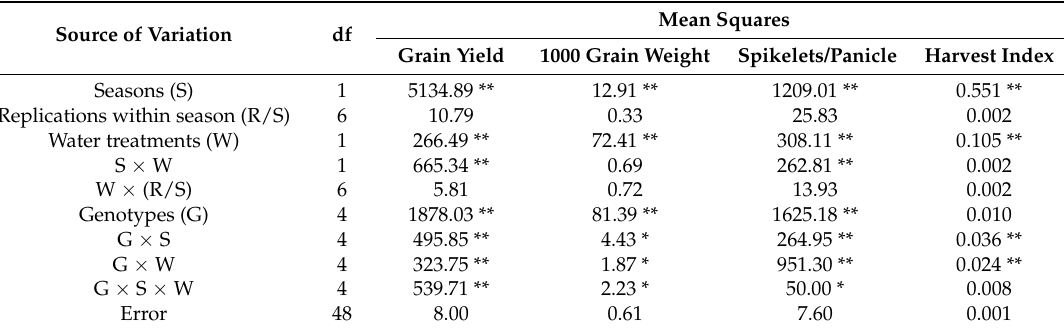
Table 6. Combined ANOVA over seasons for yield and yield components. Source of Variation